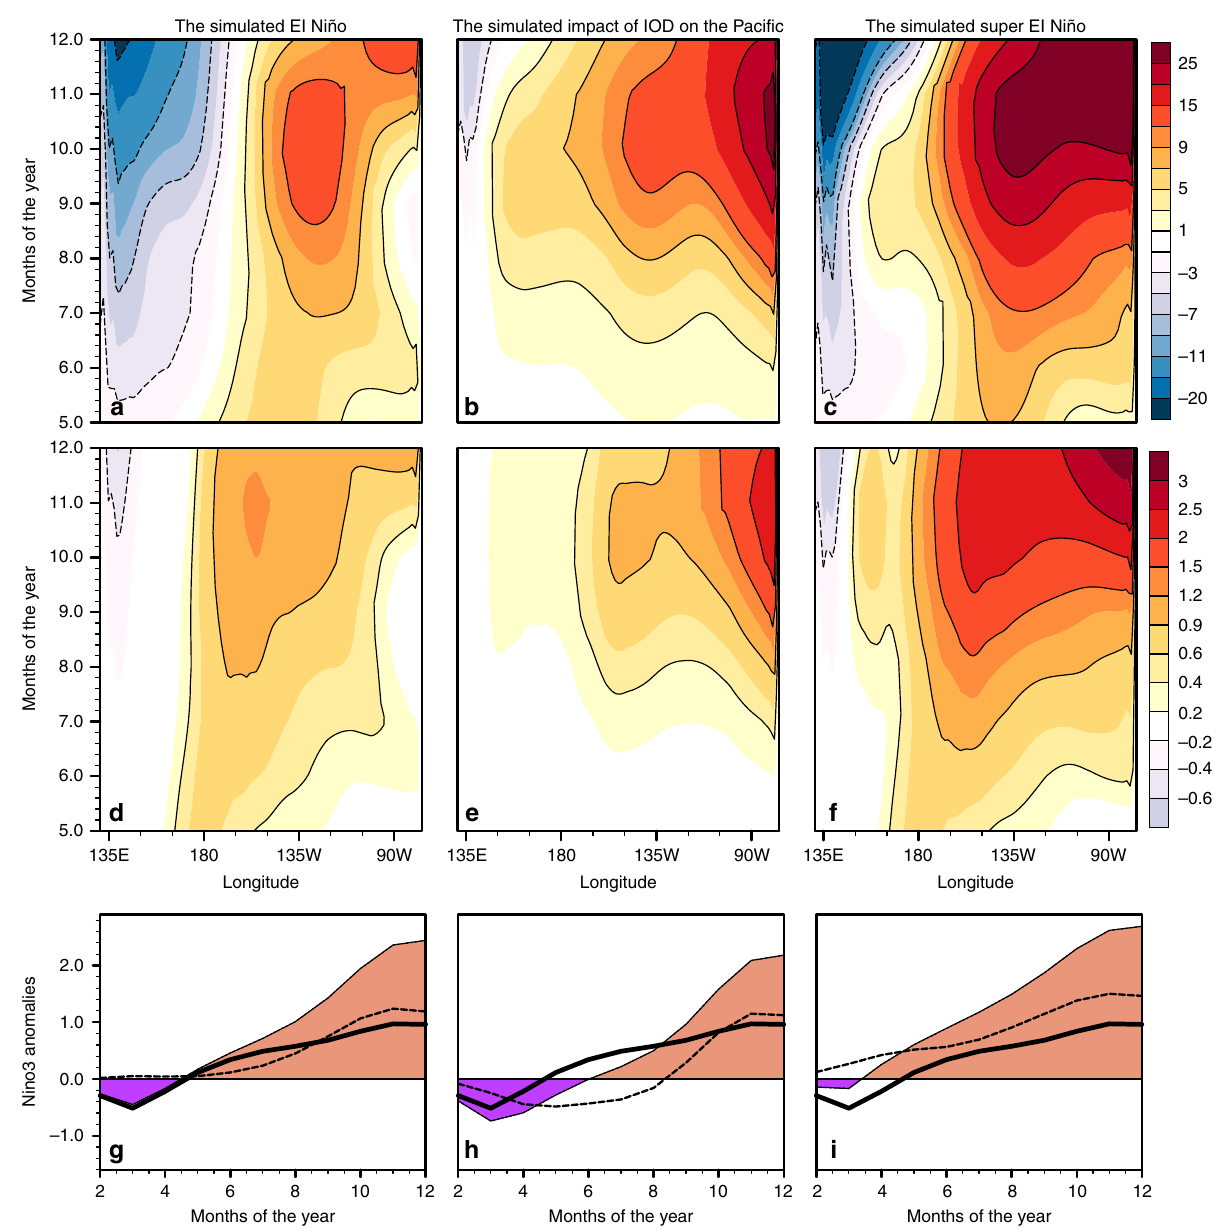
Fig. 9 Thermocline and SST anomalies during a simulated super El Niño. In this simulation, we drove an ocean model after augmenting Paci fi c wind anomalies during El Niño with IOD-induced Paci fi c wind anomalies — the wind anomalies were from atmospheric simulations. The contributions of El Niño and IOD to the simulated super El Niño are separately shown in a , d and b , e respectively — panels a , b show thermocline anomalies, while panels d , e show SST anomalies. c Thermocline anomalies, and f SST anomalies, associated with the simulated super El Niño. g Temporal evolution of Nino3 anomalies calculated from the SST anomalies shown in d – f : the dashed line is the contribution from IOD, the solid line from El Niño, and the shaded curve is that for the simulated super El Niño. Panels h , i are from additional ocean simulations, where two different realizations of IOD-induced Paci fi c winds drove the ocean. In h the impact of IODs occurring without El Niño, and in i that of IODs co-occurring with El Niño were simulated (see text for details of the atmospheric simulations). Note that the IOD-induced part of Nino3 SST anomalies are stronger in i than in h . The observational analog of a , b , d , e